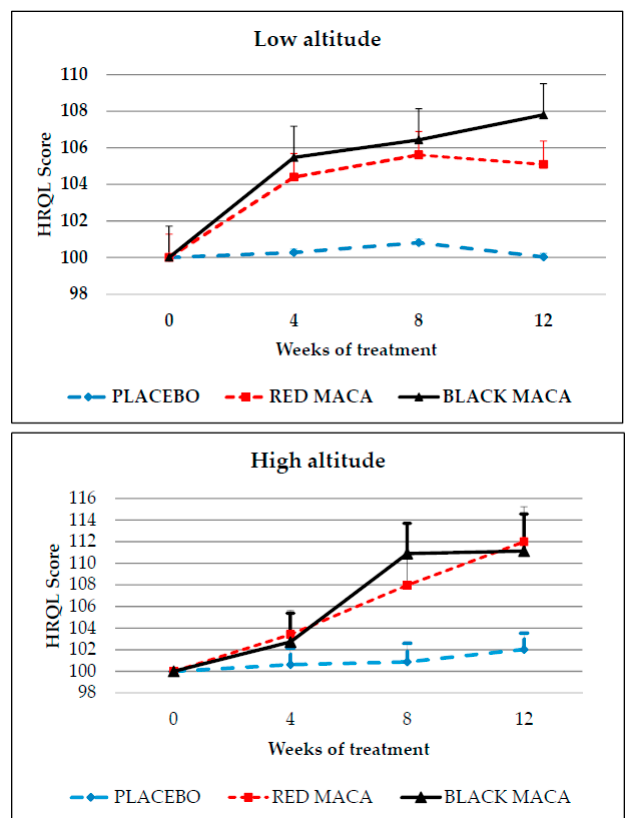
Figure 4. Heath-Related Quality of Life Score (HRQL) in subjects receiving a 12-week treatment of a placebo, spray-dried extract of red maca, or spray-dried extract of black maca at low ( Upper ) or high altitude ( Bottom ). Data are mean ± standard error of the mean. Upper : LA: Placebo group: p > 0.05 with respect to time 0. Red maca group: p < 0.05 at week 8 and p < 0.01 at week 12 with respect to time 0 (one tail). Black maca group: p < 0.05 at week 4 with respect to time 0 and p < 0.01 at weeks 8 and 12 (one tail). p < 0.05 comparing red maca group with placebo group at eight and 12 weeks of treatment and p < 0.05 at week 4, and p < 0.01 at weeks 8 and 12, comparing the group treated with black maca with the group treated with a placebo; Bottom : HA: placebo group: p > 0.05 with respect to time 0. Red Maca group: p < 0.05 at week 8 and p < 0.01 at week 12 with respect to time 0. Black maca group: p < 0.01 at weeks 8 and 12 with respect to time 0. p < 0.05 black and red maca groups at weeks 8 and 12 with respect to the placebo group.